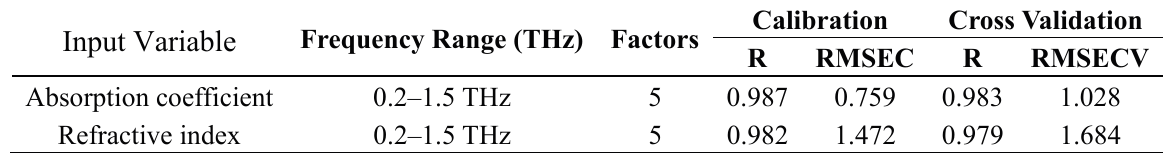
Table 2. Calibration and validation results obtained with the effective spectrum PLS Model.